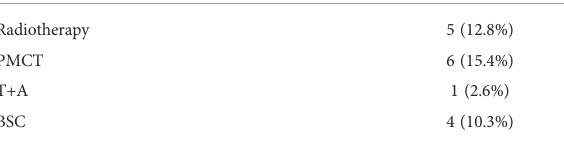
P = 0.30, Figure 3D). Repeated TACE appeared to show survival advantage over a single TACE treatment, but the statistical difference was not signi fi cant ( P = 0.08, Figure 3E; P = 0.48, Figure 3F). The results of subgroup survival analysis according to (I) the types of PVTT, (II) the presence or absence of